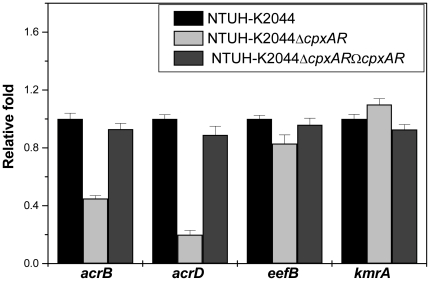
Quantification of the transcript levels of multidrug transporter genes that belong to RND-type and MFS-type efflux pumps.Relative transcriptional levels of acrB, acrD, eefB, kmrA in NTUH-K2044ΔcpxAR and NTUH-K2044ΔcpxARΩcpxAR strains determined using real time RT-PCR is showed in comparison with wild type. The wild type expression level is represented as one fold. Each bar represents the average value of three independent experiments. Error bars are standard deviations.